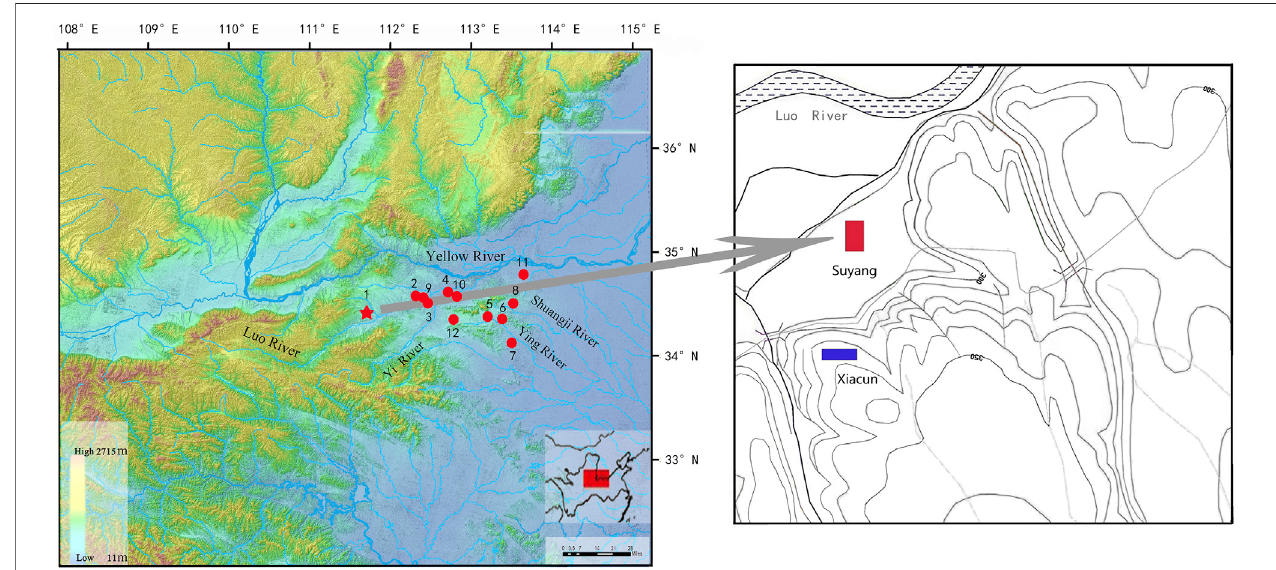
FIGURE 1 | Map showing the location of sites mentioned in the text: (1. Suyang, 2. Zhonggou, 3. Wanggedang, 4. Erlitou, 5. Wangchenggang, 6. Chengyao, 7. Wadian, 8. Xinzhai, 9. Zaojiaoshu, 10. Huizui, 11. Zhuzhai, 12. Yingyang) and the spatial distribution of excavation areas of the Suyang site.